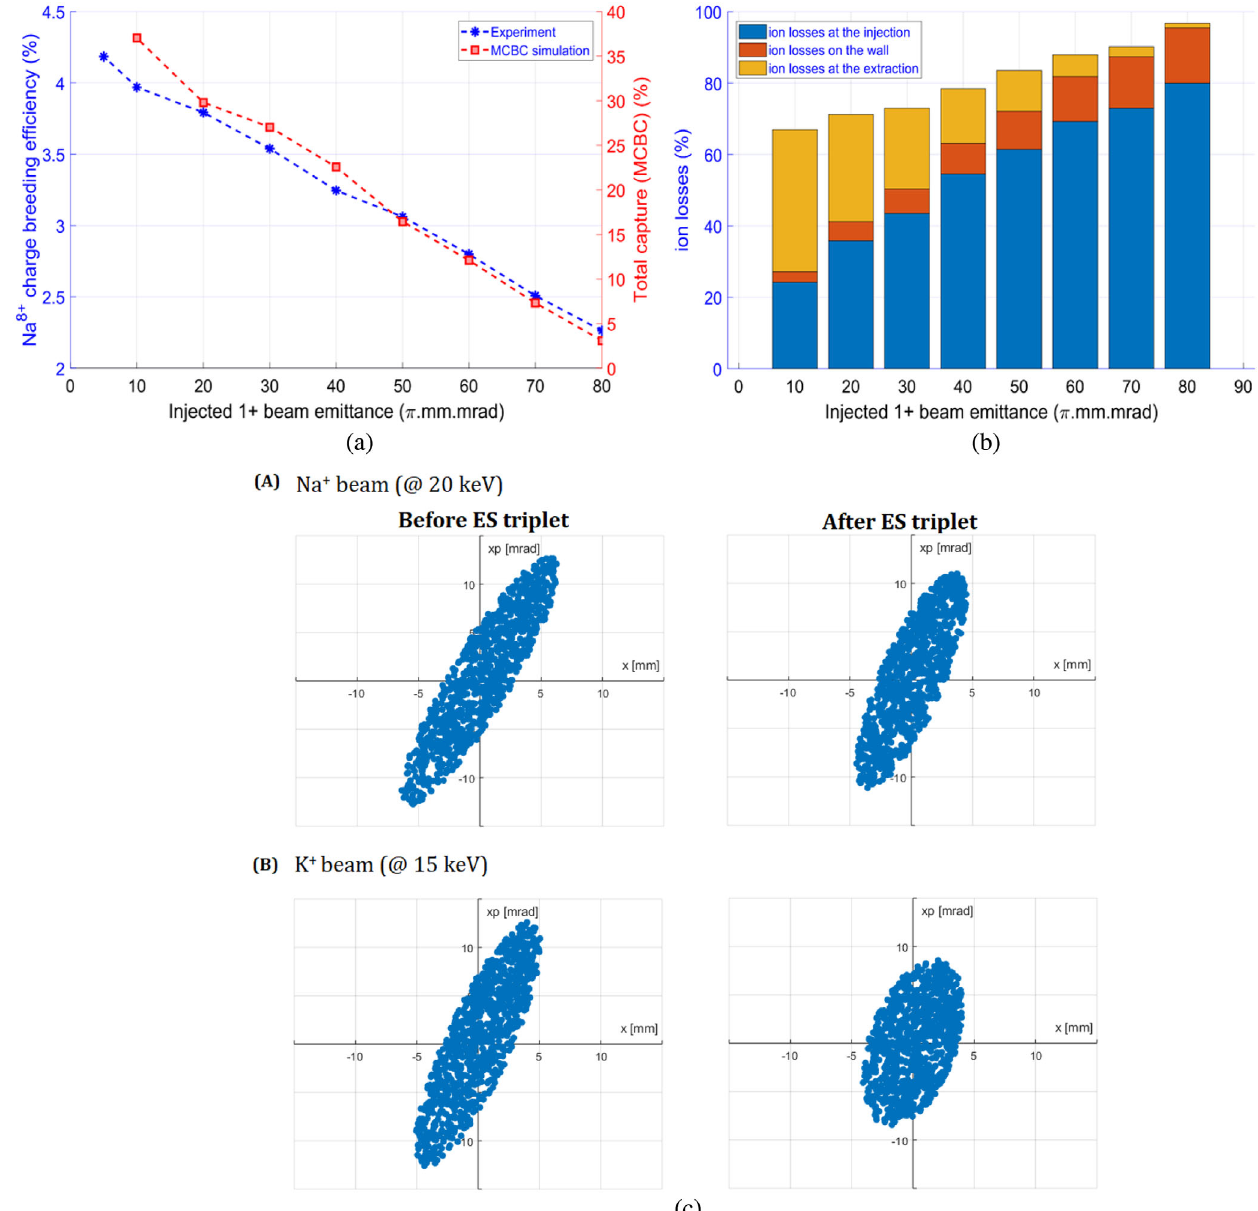
FIG. 14. (a) Comparison between the experimental Na 8 þ charge breeding efficiency and the total 1 þ ion capture from MCBC. (b) Total number of 1 þ ions lost in the simulation domain (reflected back, lost to the wall, and lost toward the extraction). (c) Simulated transverse beam positions of 20 keV Na 1 þ beam (top) and 15 keV K 1 þ beam (bottom) before and after the injection optics (electrostatic